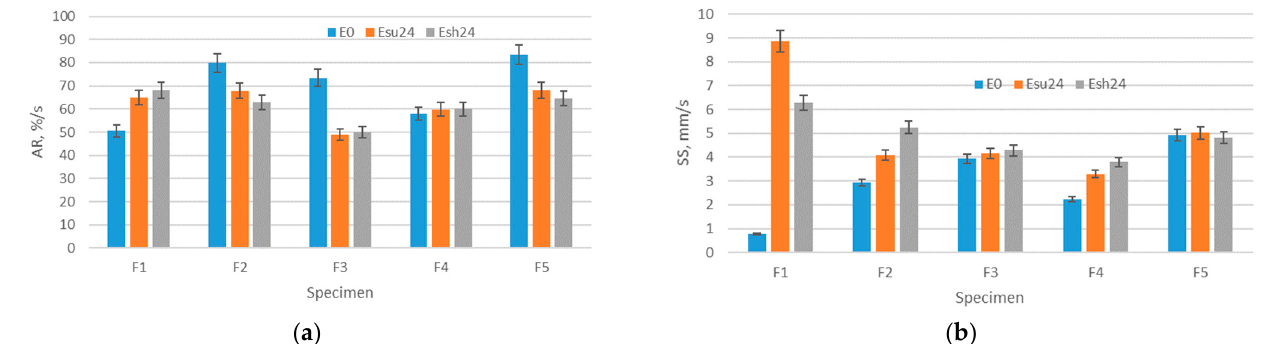
Figure 12. Average values and standard deviation of the properties related to moisture management: ( a ) AR and ( b ) SS of polymer materials.